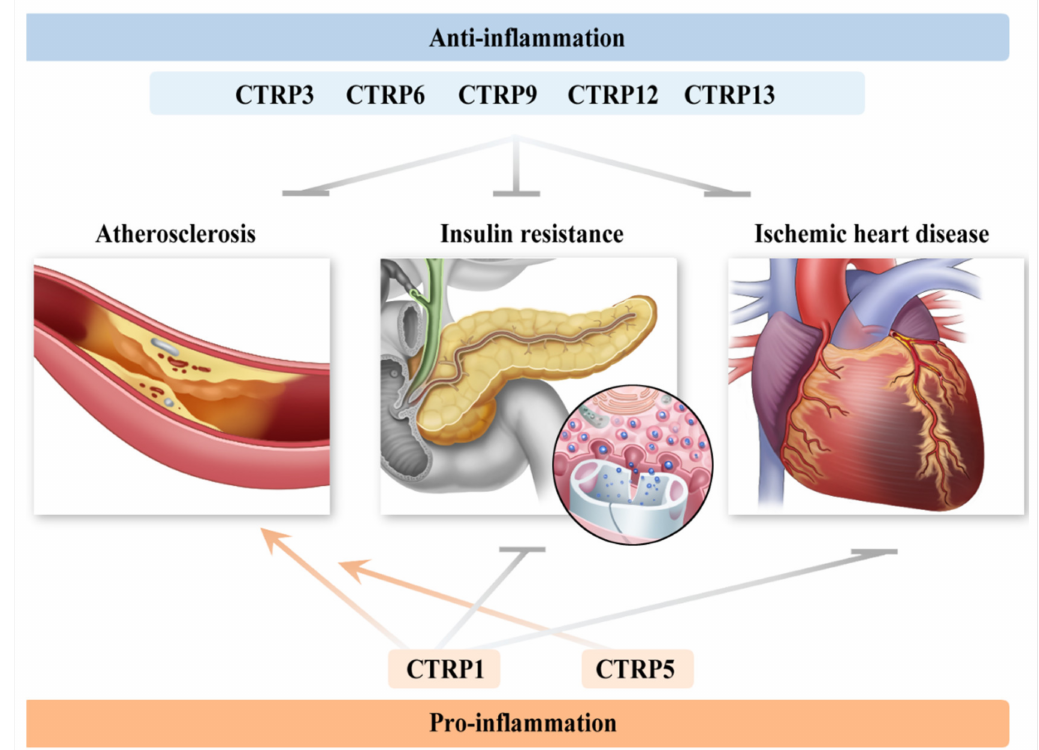
Figure 3. Major C1q/TNF-related protein (CTRP) isoforms participating in cardiometabolic homeostasis. The respective members of the CTRP family exert different actions on each organ, among which CTRP3, CTRP6, CTRP9, CTRP12, and CTRP13 promote an anti-inflammatory response. CTRP1 and CTRP5 are recognized to trigger inflammation and atherogenesis, whereas CTRP1 plays a protective function in insulin sensitivity and ischemic heart disease. However, the role of CTRP5 in diabetes and cardiac disease is still